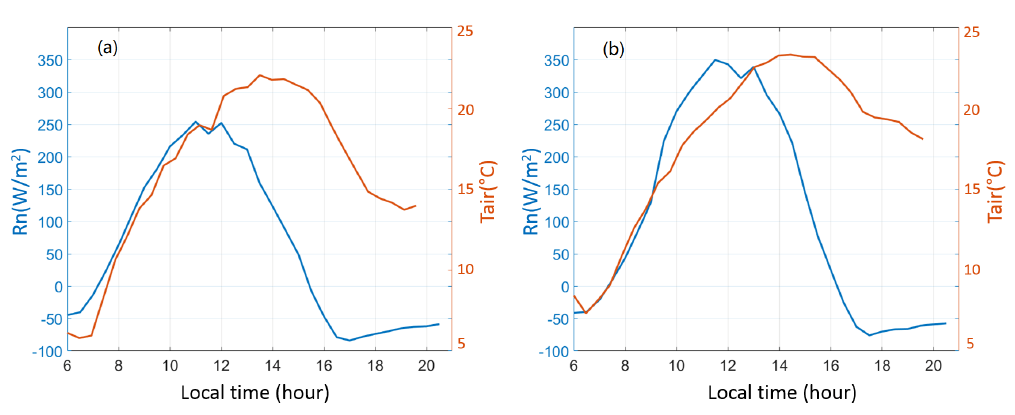
Figure 2. Diurnal variations of net radiation (blue line) and air temperature (red line) at the meteorological station for 13 December 2016 ( a ) and 31 January 2017 ( b ). Table 1. Flight characteristics and meteorological conditions for the 13 December 2016 campaign.